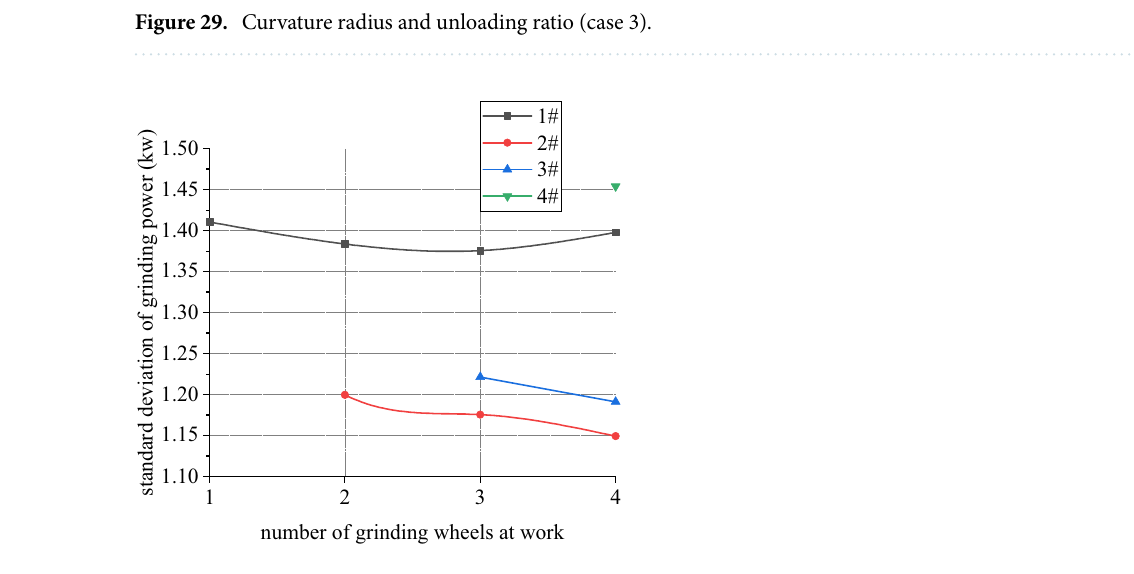
Figure 30. Grinding wheels and grinding power (case